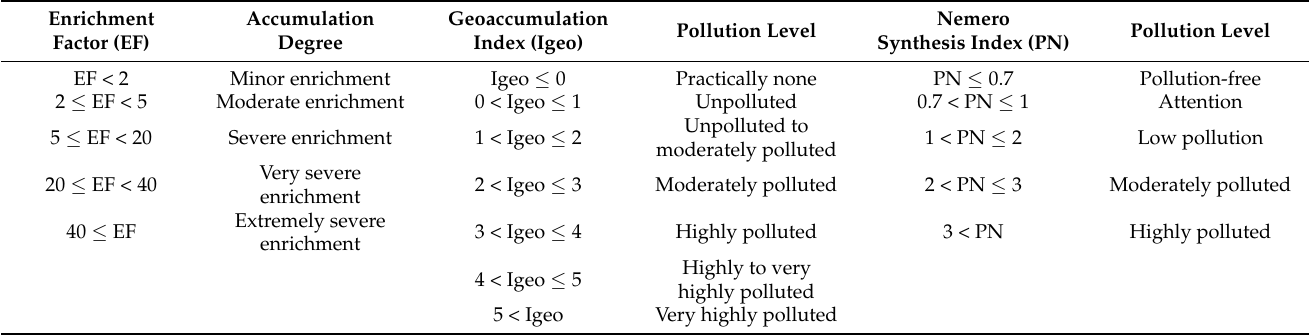
Table 2. Enrichment factors (EFs), geoaccumulation (Igeo), Nemero synthesis indices (PN), and contamination